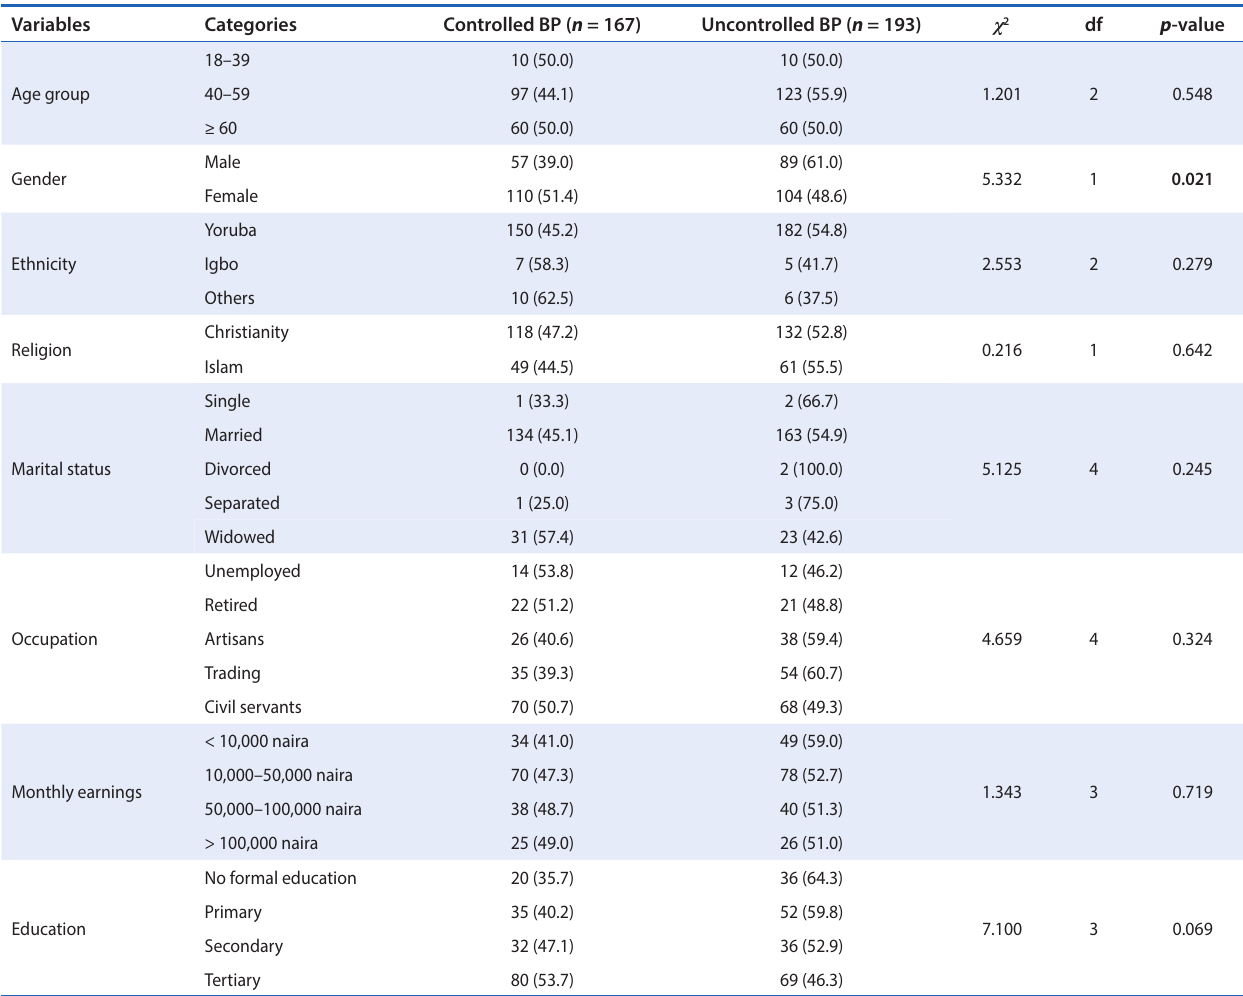
There was a significant association between BP control and gender.